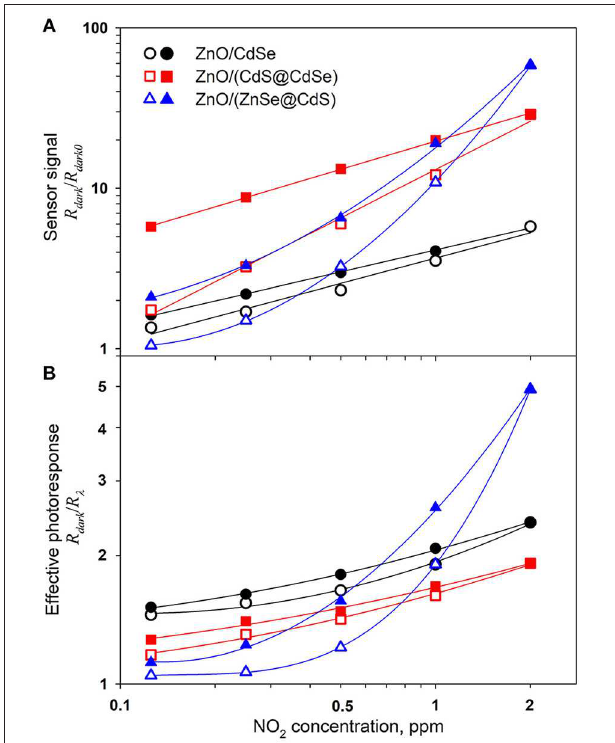
FIGURE 10 | Sensor signal S = R dark /R dark0 (A) and effective photoresponse P eff = R dark /R λ (B) of ZnO/CdSe, ZnO/(CdS@CdSe), and ZnO/(ZnSe@CdS) nanocomposites under periodic green light illumination ( λ max = 535nm) with increasing (open symbols) and decreasing (filled symbols) NO 2 concentration in the gas